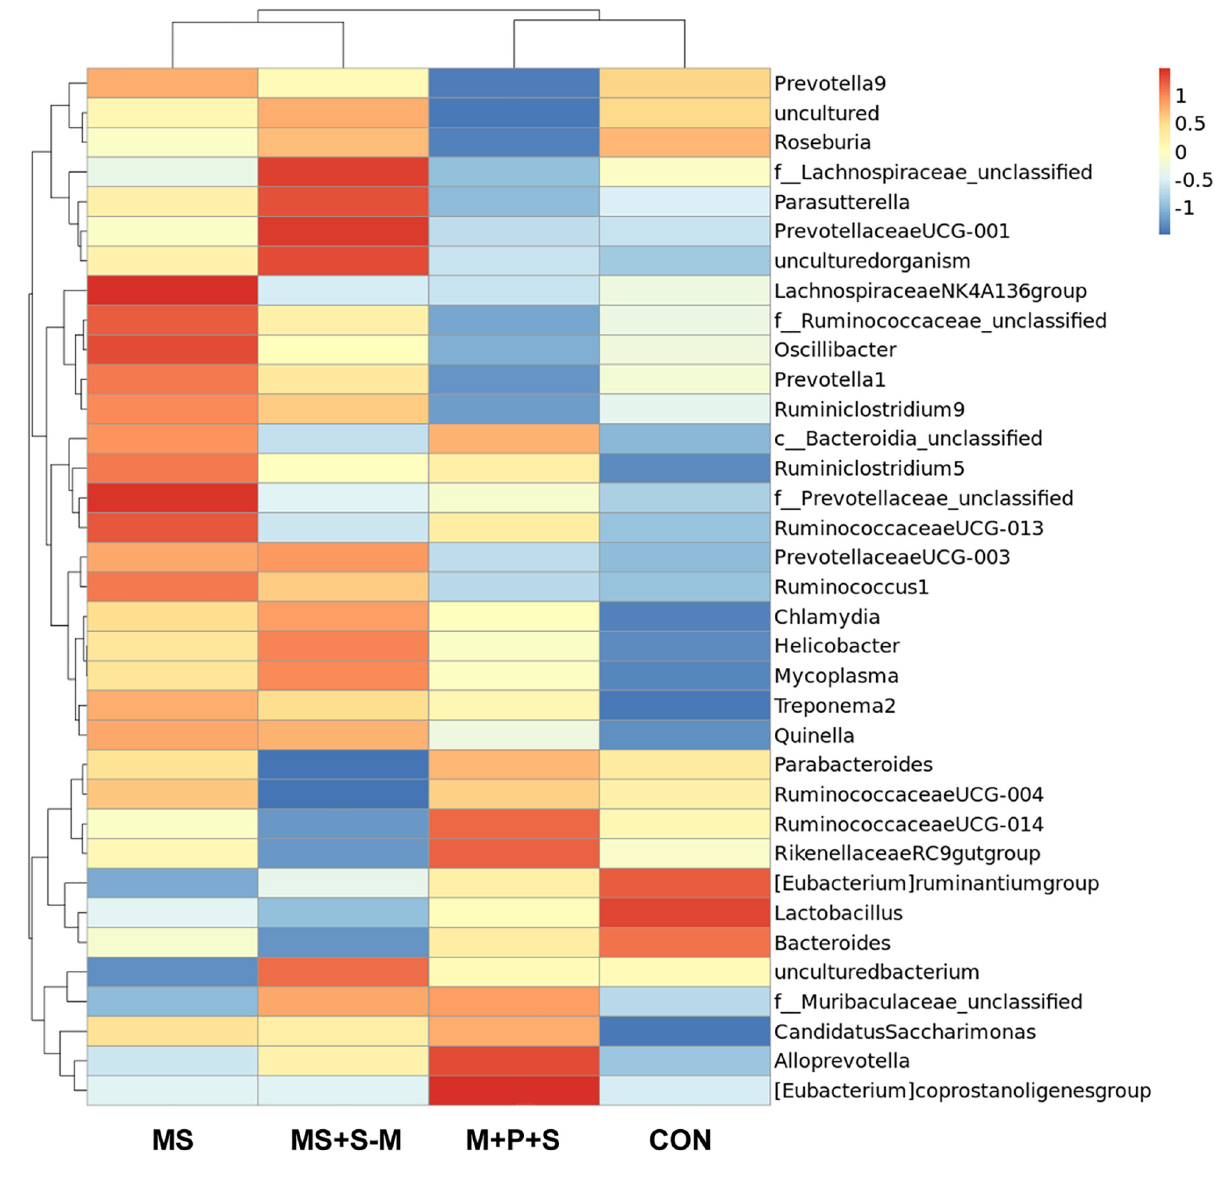
MS + Pro ( P < 0.001) and MS + S − M + Pro ( P < 0.001)